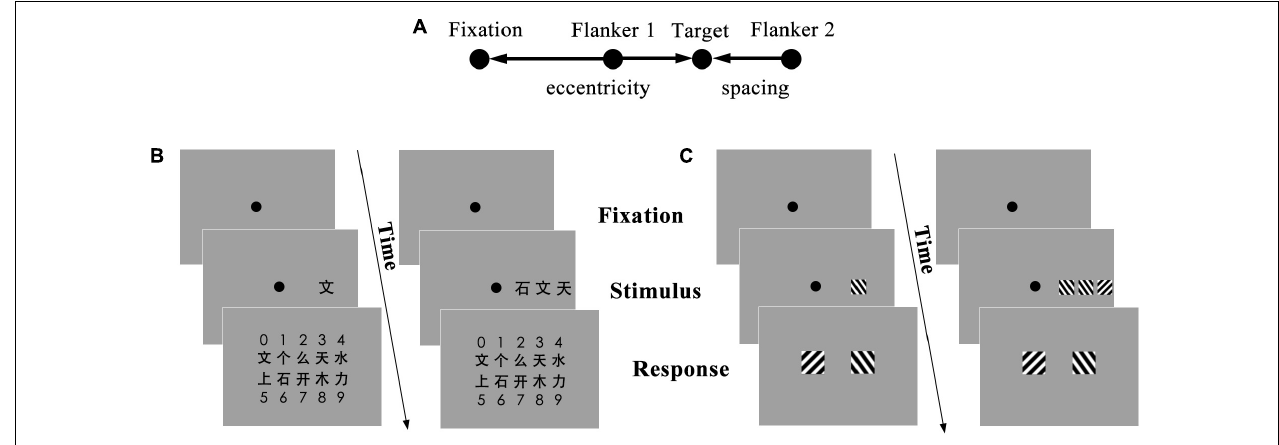
FIGURE 1 | The procedure of the visual crowding test. (A) Definition of the typical parameters for crowding. Critical spacing is the center-to-center distance between the target and flanker, and eccentricity is the distance between the target and fixation. (B) In the uncrowded condition (left) of the Chinese characters (VCC) test, only a single character (the target) is presented. In the crowded condition (right), three characters (the target is in the middle) are presented. During the response period, the subject chooses the target from 10 Chinese characters by pressing a key. (C) The procedure of the visual crowding test for gratings (VCG). The uncrowded gratings condition is on the left, and the crowded condition is in the right. The fixation point is in the center of the